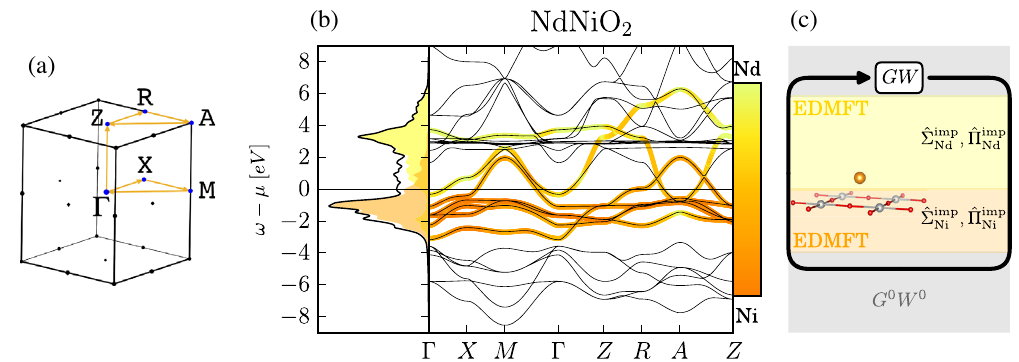
FIG. 1. Low-energy model and computational scheme. (a) First Brillouin zone of NdNiO 2 and high-symmetry lines. (b) LDA band structure and low-energy space spanned by seven bands of predominantly Nd and Ni character. (c) Schematic representation of the multitier GW þ EDMFT framework: In a first step, the bare propagators and frequency-dependent bare interactions of the low-energy model are obtained from a single-shot G 0 W 0 downfolding. Then, two impurity problems, for Ni and Nd, respectively, are defined and self-consistently solved considering retarded interactions, which account for screening effects. To the corresponding local self-energies and polarizations, we add nonlocal contributions evaluated at the GW level. These frequency- and momentum-dependent objects enter into the EDMFT lattice self-consistency